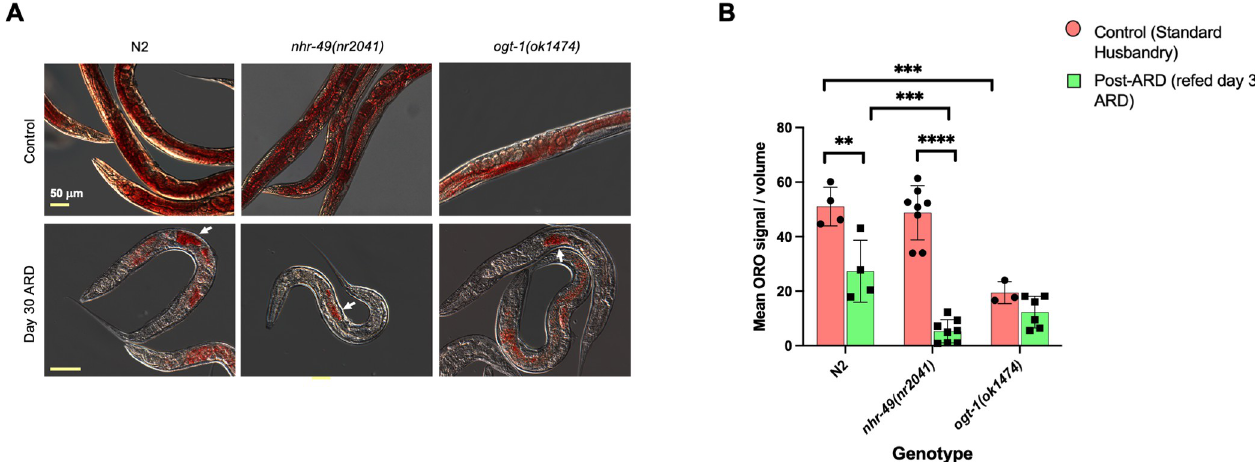
Fig 5. Oil Red O staining reveals redistribution of lipid stores in ARD. (A) Representative images showing the distribution of Oil Red O in control (top) and starved animals after day 30 of ARD (bottom) in the ogt-1- dependent pathway. Retention of TAGs appeared to be strongest in the retained embryos in all mutant strains (white arrows). Scale bar indicates 50 μ m and is consistent across each row. (B) Fiji Image analysis-based quantification of ORO staining (see S1 Methods) of wildtype and the mutant strains of the ogt-1- dependent pathway in normal husbandry (control) and in day 30 of ARD. Using two-way ANOVA analysis, both variables (genotype and feeding condition) were found to have significant effects, and these variables interact significantly. For each strain, mean ORO density decreased after 30 days of ARD: most dramatically for nhr-49(nr2041) and not significantly for ogt-1(ok1474) . In normal husbandry conditions, ogt-1(1474) showed significantly less ORO signal than did N2 worms. P- value ���� = < 0.0001, ��� = < 0.001, �� = < 0.01. Error bars represent standard